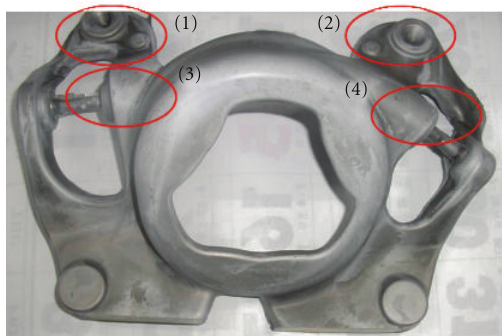
Figure 16: Fabricated module bracket and position of microstruc- ture (initial slurry temperature: 600 ◦ C, punch velocity: 50mm/sec and solid fraction: 70%).